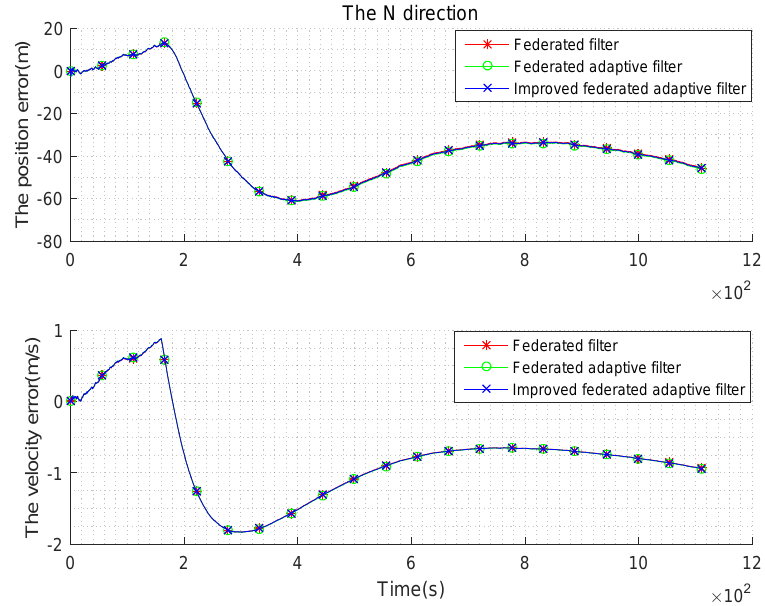
Figure 5. Comparison of the navigation error with Gaussian state noise and unbiased estimation in N